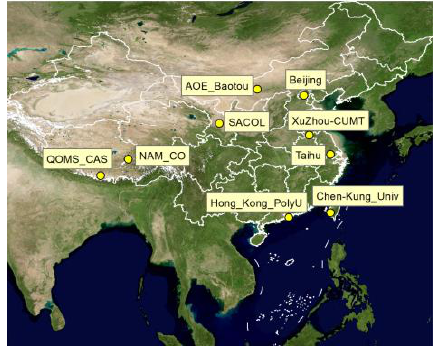
Figure 1. AERONET sites distributions in the study